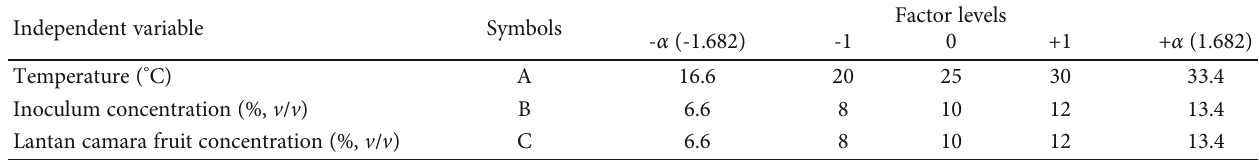
Table 2: Independent variable values of the process and their corresponding factor levels.